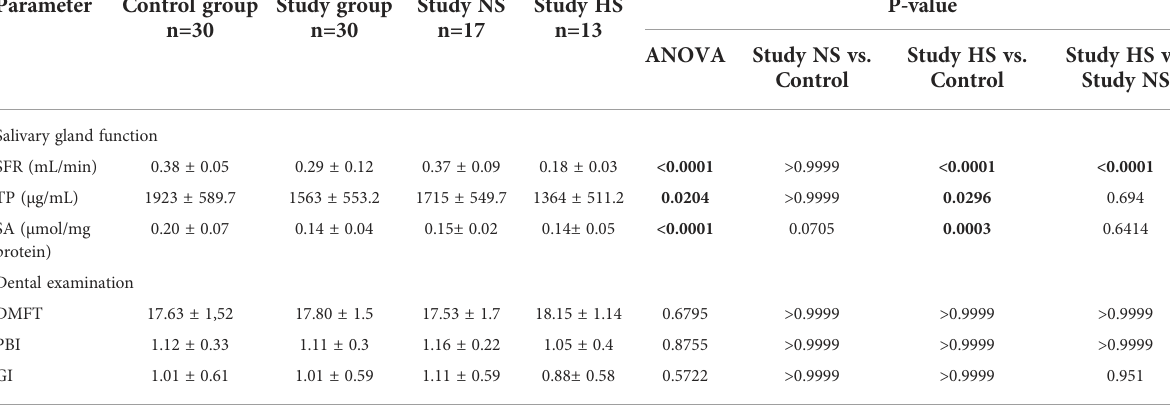
DMFT, decayed, missing, fi lled teeth index; GI, gingival index; HS, hyposalivation; NS, normal salivation; PBI, papilla bleeding index; SA, salivary amylase; SFR, saliva fl ow rate; TP; total protein content. Bold indicates statistically signi fi cant